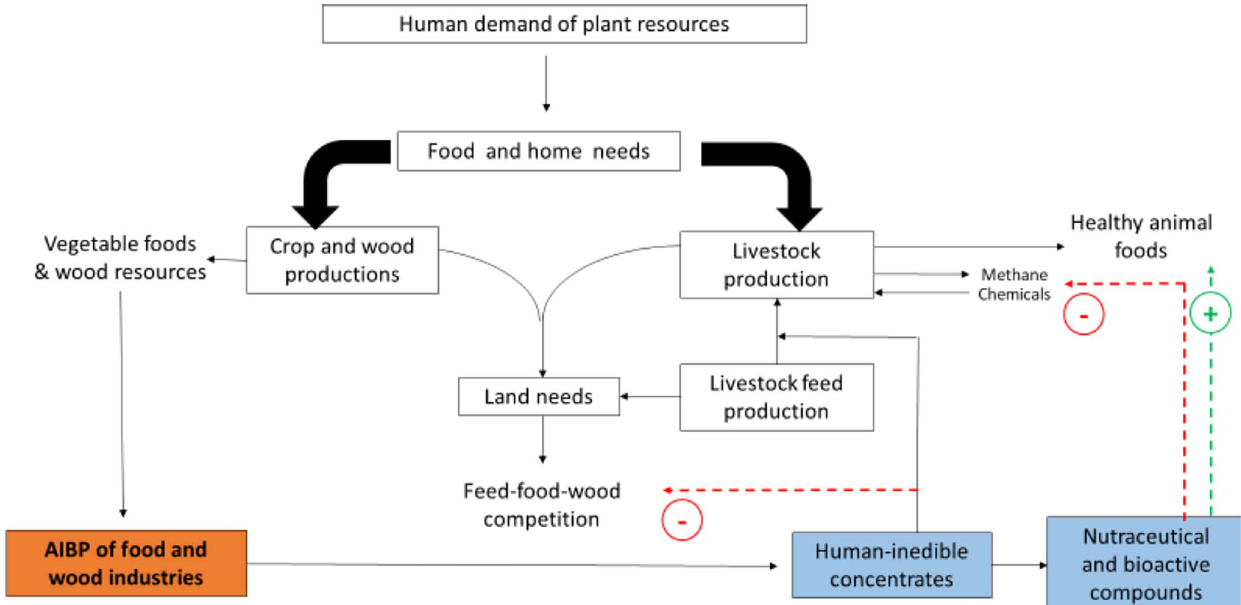
Figure 1. Bene fi cial role of the use of agro-industrial by-products (AIBPs) in animal production . A framework to develop the circular economy, including the potential effects on animal health through the use of nutraceuticals (Adapted from